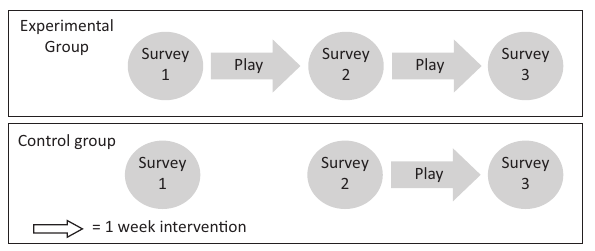
FIGURE 1: Research TABLE 3: Data distribution. Variable